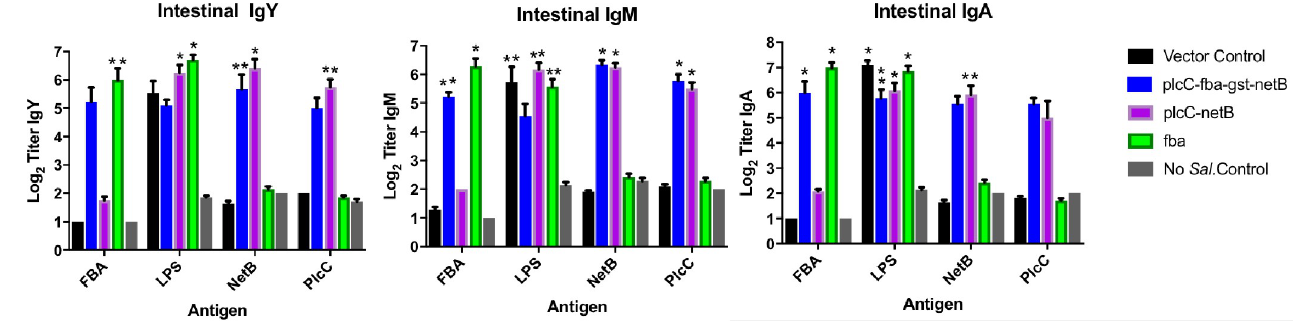
Fig 3. Mucosal antibody responses to the indicated C . perfringens proteins and Salmonella LPS as determined by ELISA in experiments 2/3. Differences in responses compared to non-vaccinates and vector-only controls are indicated by � , P < 0.0001; �� , P < 0.02. LPS responses were compared to non-vaccinated controls.